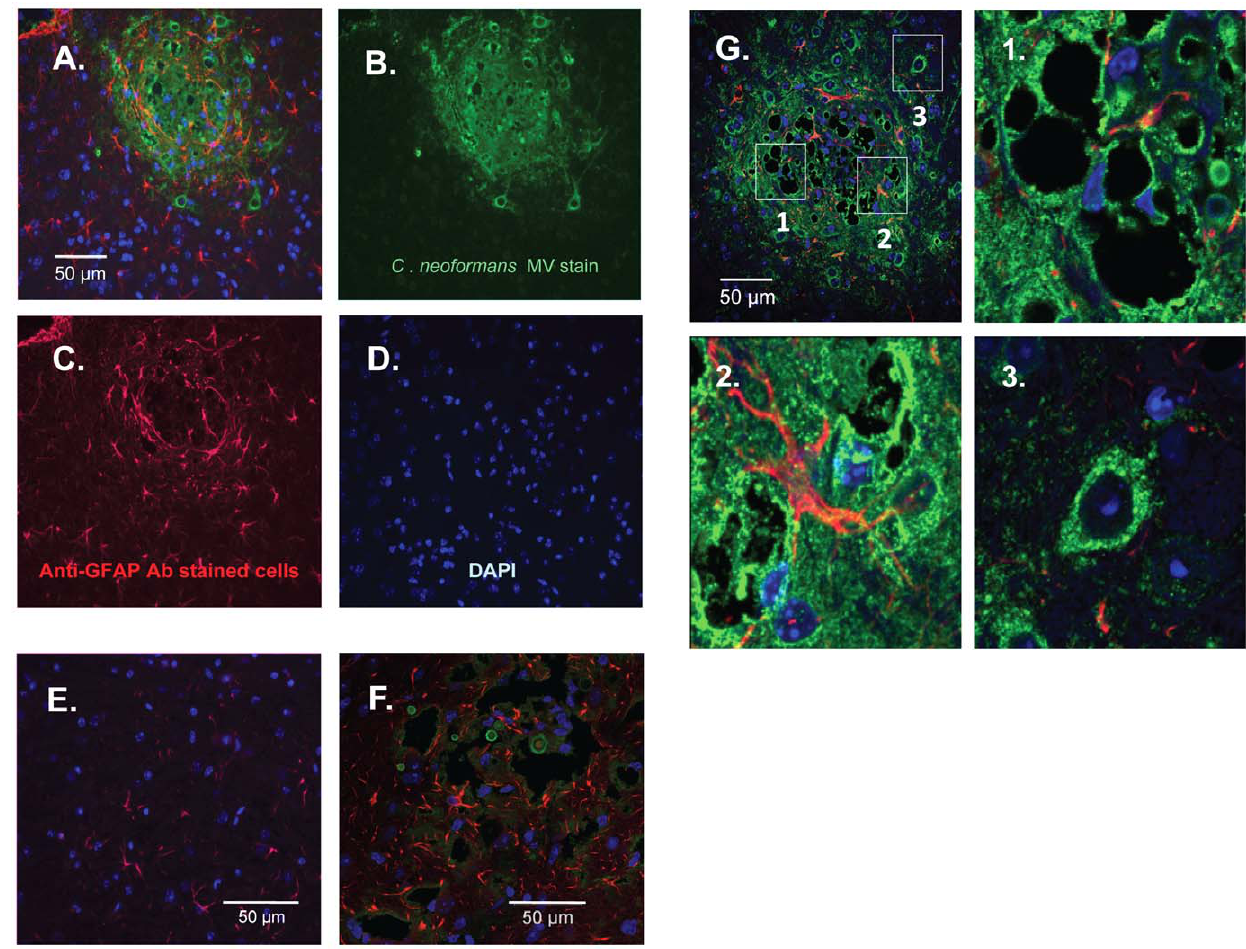
Figure 7. Distribution of the CnMV marker and glial cells around C.neoformans -induced cystic lesion in infected brains. C57LB/6 mice were infected with 10 6 C. neoformans JB02 cells for 10 days. Brain sections were stained with an anti-GFP antibody to detect the CnMV marker 14-3-3- GFP (green) ( B ), an anti-GFAP (glial fibrillary acidic protein) antibody to detect host astrocyte cells (red) ( C ), and DAPI for the localization of brain cells (blue) ( D ). Image ( A ) is the overlaid image of (B, C, D). Image ( E ) is a section of an uninfected brain with no detectable staining for GFP. The C. neoformans strain C1186 was used to infect mice for comparison; green yeast cells were evident but CnMVs could not be detected in brain sections ( F ). A confocal image of a typical cystic lesion after 16 days of infection is shown in ( G ). Enlarged regions (box 1, 2, and 3) in image ( G ) are displayed in ( 1 ), ( 2 ) , and ( 3 ), and their corresponding videos are provided in Supplement V(1), V(2), and V(3), respectively. Bar=50 m m.